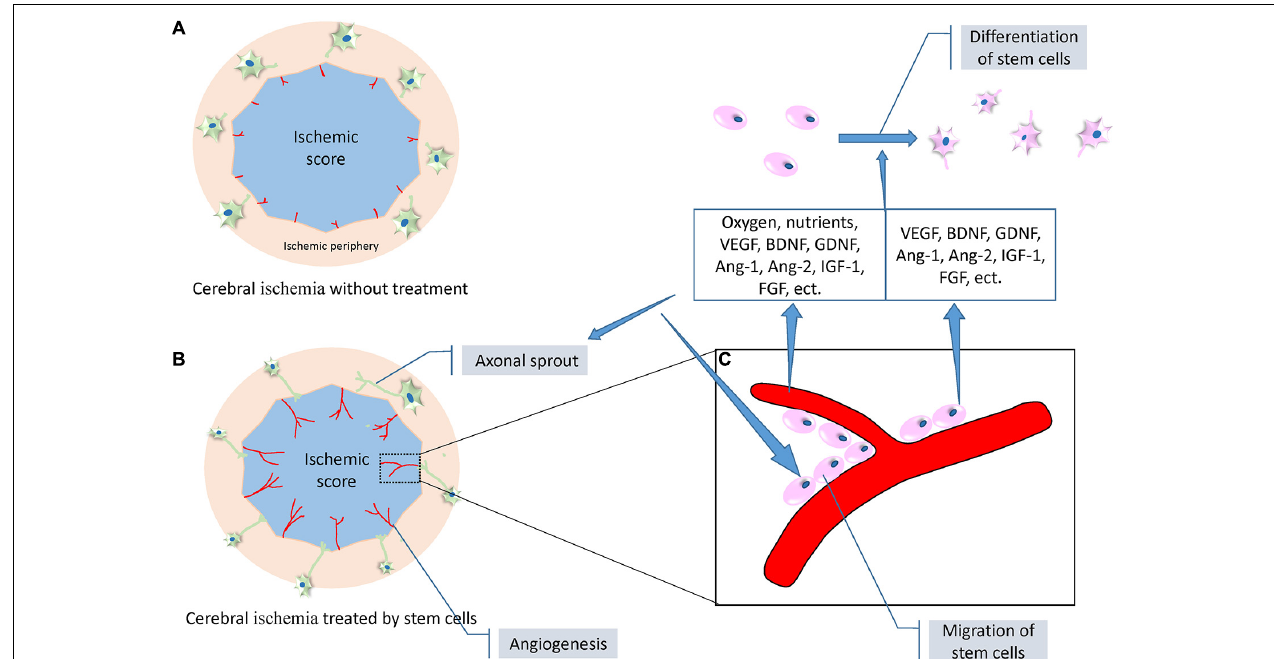
FIGURE 4 | A set of diagrams of angiogenesis, neurogenesis, and axonal outgrowth under the treatment of stem cells following ischemic stroke (modified from the reference of Masato Kanazawa et al., 2019). (A) A proposed diagram depicting the location of angiogenesis and axonal outgrowth after ischemic stroke without intervention. Weak angiogenesis (red lines) occurs at the border of the ischemic core (blue) and peripheral areas, and limited axonal sprouting occurs in the neurons (green cells) of the peripheral areas. (B) A proposed diagram depicting enhanced angiogenesis and evident axonal sprouting and outgrowth under the treatment of stem cells. (C) A representative diagram expanded from a certain area of the diagram in ( B ). Stem cells (pink) adhering to the newly formed blood vessels to achieve migration. The blood vessels and stem cells themselves secrete a variety of neurotrophic factors including VEGF, BDNF, GDNF, Ang-1, Ang-2, IGF-1, and FGF. In addition, blood vessels release additional oxygen and nutrients to promote the proliferation, migration, and differentiation of stem cells, and axonal outgrowth. Abbreviations: VEGF, vascular endothelial growth factor; BDNF, brain-derived neurotrophic factor; GDNF, glial cell-derived neurotrophic factor; Ang-1, angiotensin 1; Ang-2, angiotensin 2; IGF-1, insulin-like growth factor 1; FGF, fibroblast growth factor.